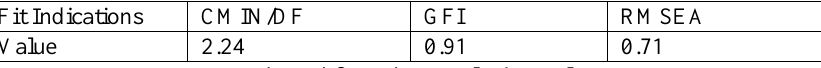
Table 2: Model Fit Statistics of the Structural Equation Model